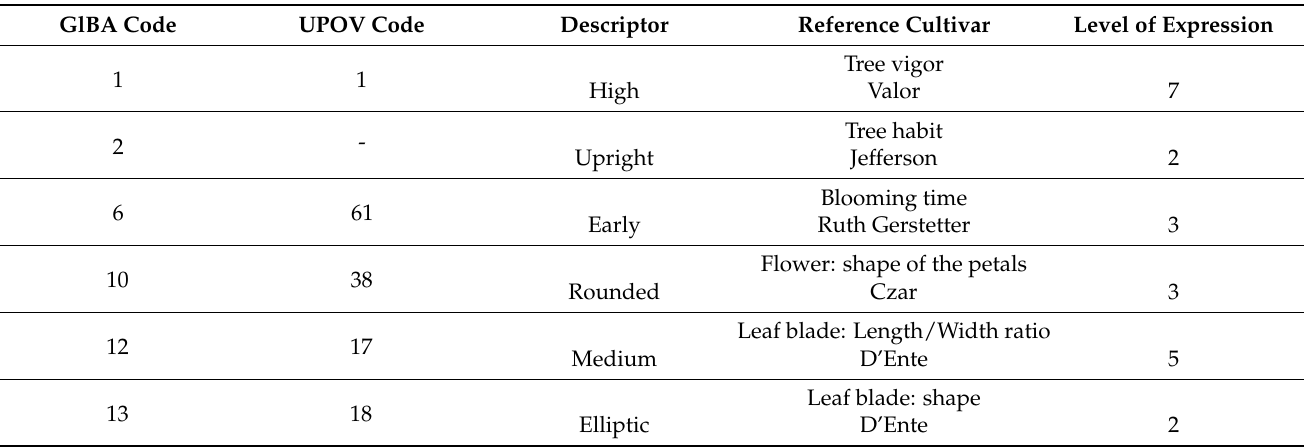
Table 1. Application of criteria for describing the morphological traits of plum tree accessions on ‘Alimena’ myrobalan based on a list of descriptors prepared under the National Agricultural Biodiversity